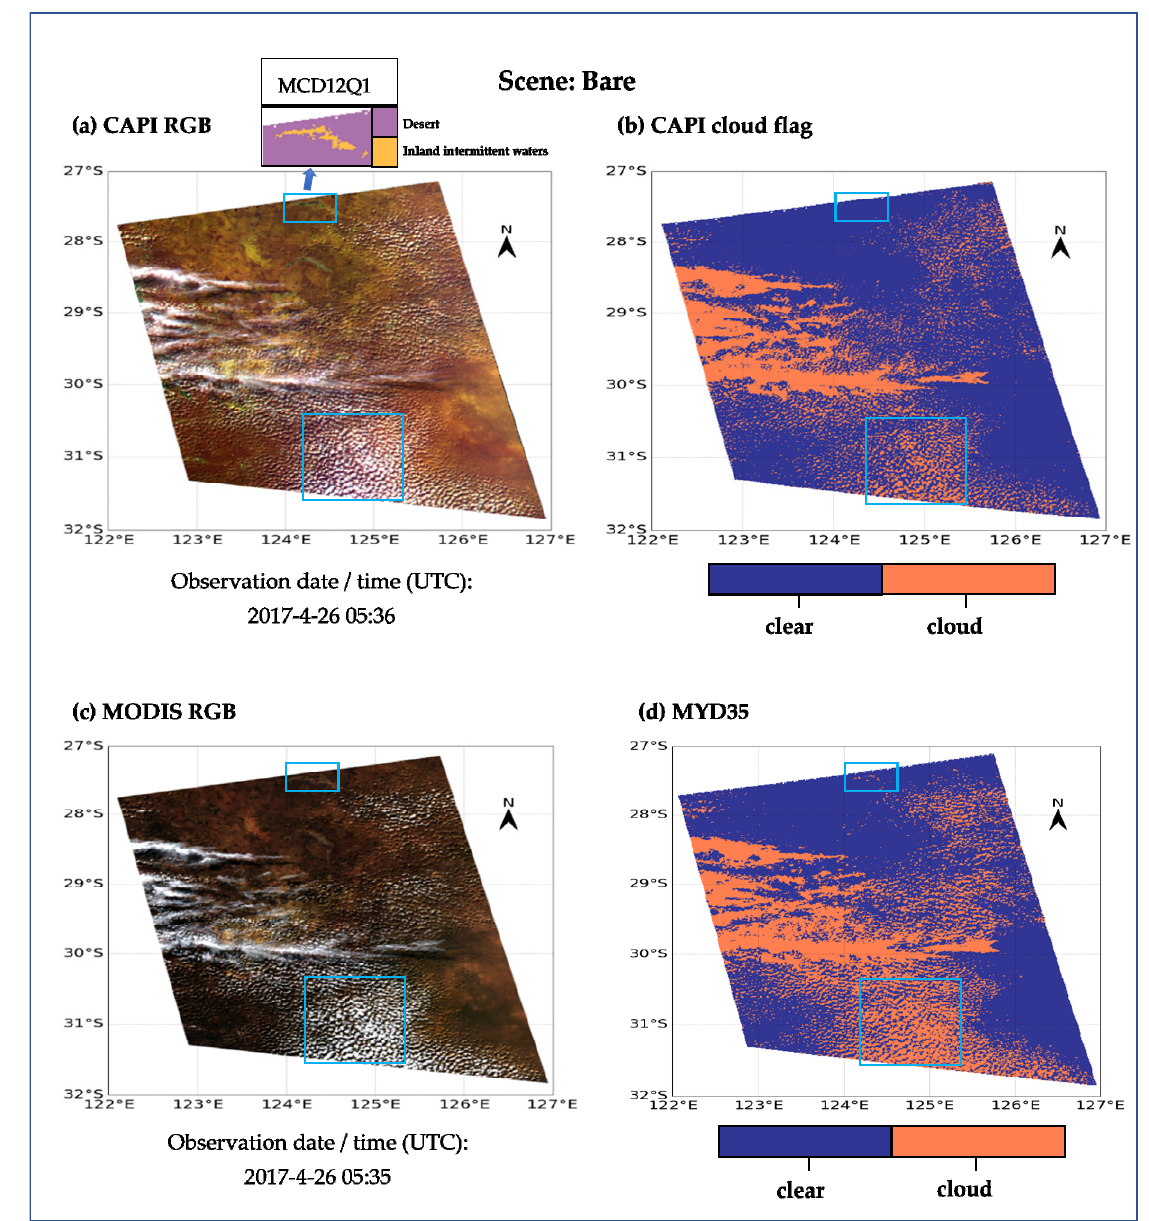
Figure 6. Same as Figure 4, but over the southwest part of Australia at 05:36 UTC 26 April 2017 for CAPI and at 05:35 UTC 26 April 2017 for MODIS.